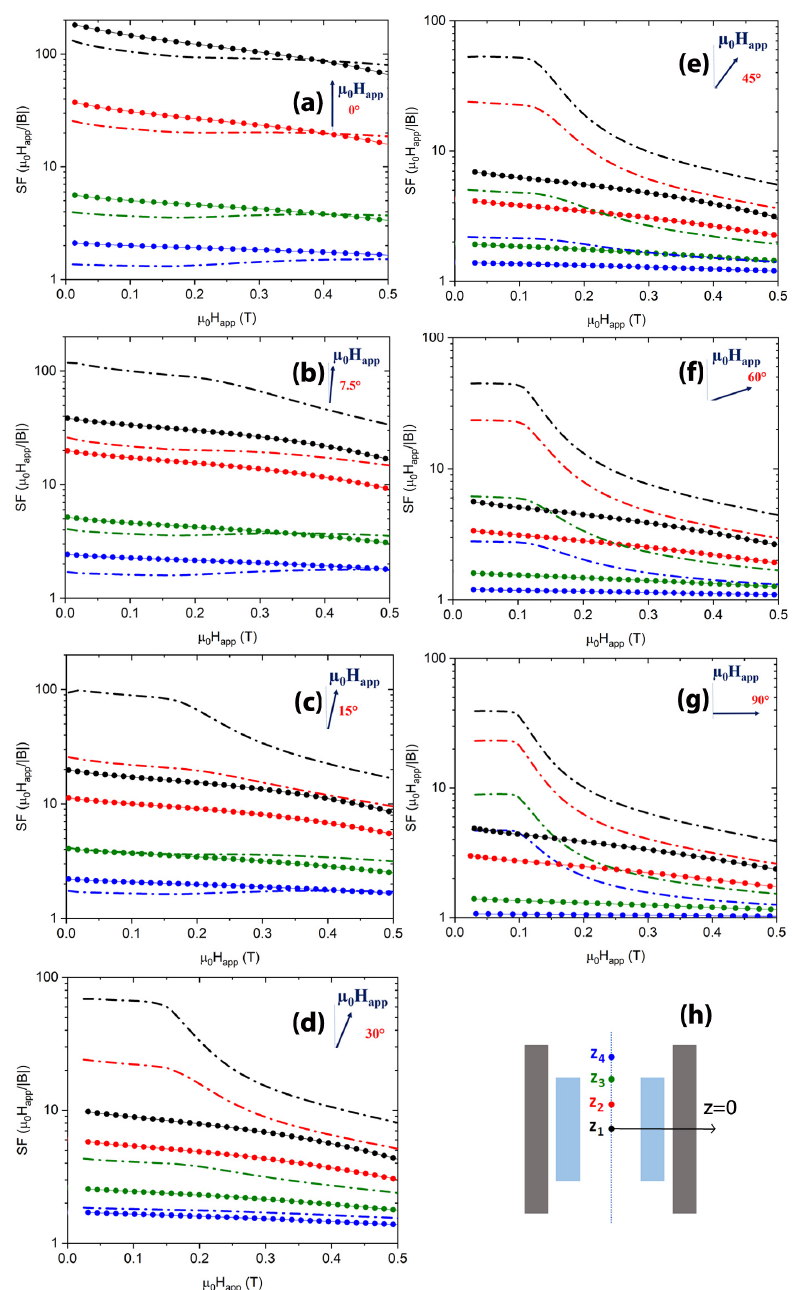
Figure 7. Comparison between the SFs of the single SC tube (dot symbols) and the configuration HTC3 (dash dot lines). Each frame ( a – g ) corresponds to a different tilt angle of the applied magnetic field. Assuming z = 0, the axial coordinate of the tube center, the curves refer to positions z 1 = 0 mm (black curves), z 2 = 4.4 mm (red curves), z 3 = 8.8 mm (green curves), and z 4 = 13.1 mm (blue curves), indicated in the HTC3 schematic view shown in the frame ( h